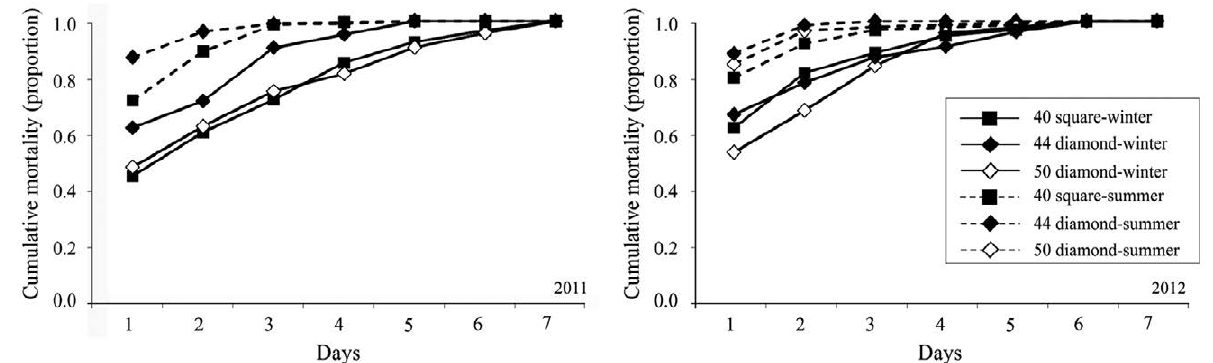
Fig. 6. – Cumulative mortality of red mullet during the observation period for the test